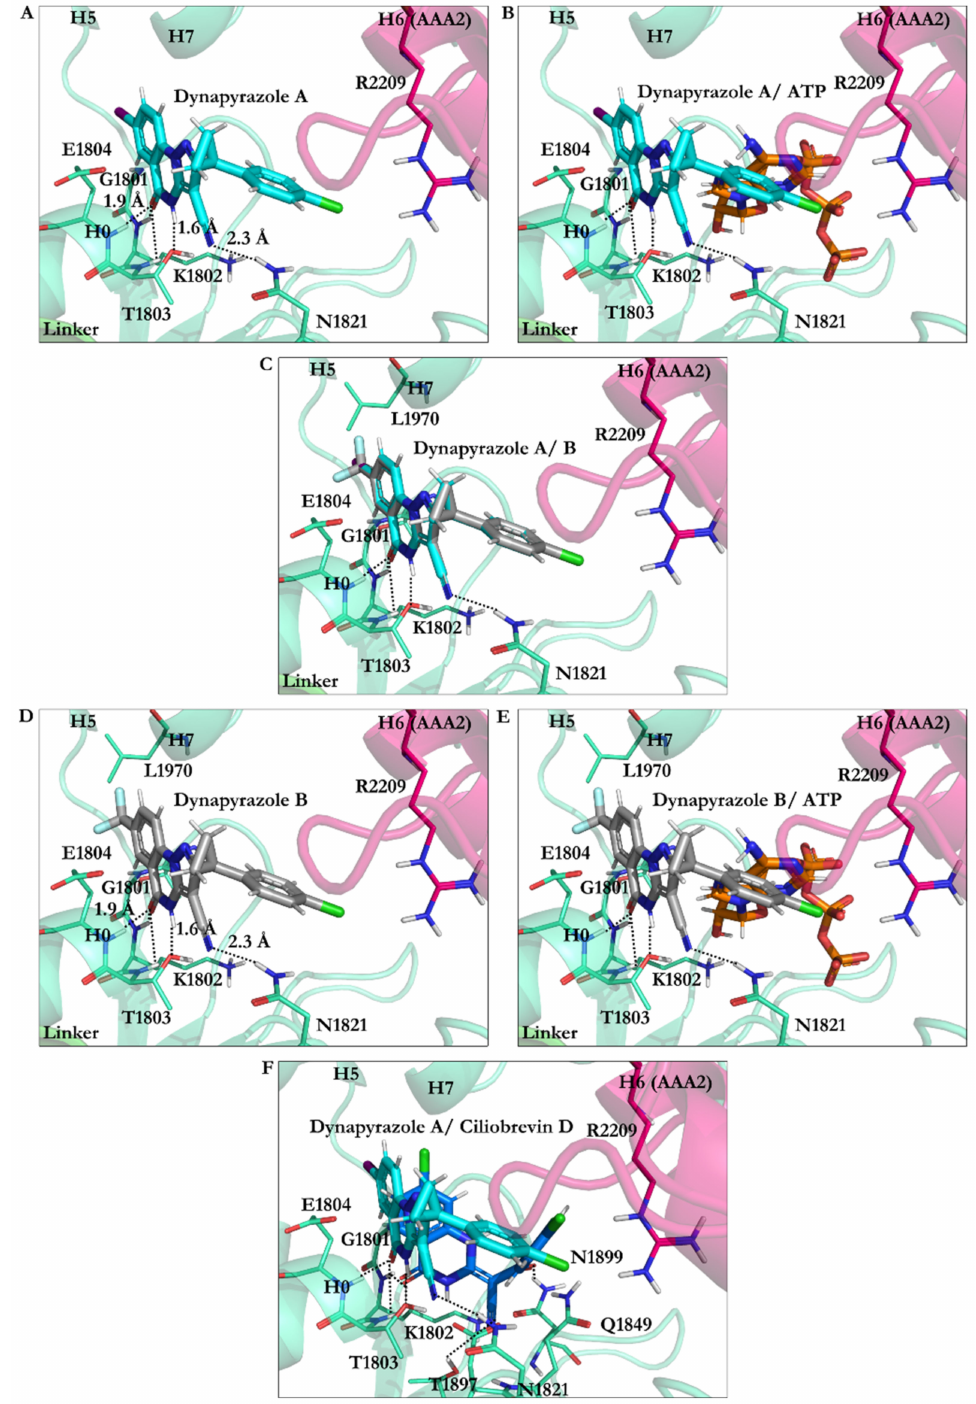
Figure 11. Dynapyrazole in the nucleotide-binding site of the AAA1 ( A ) dynapyrazole A. ( B ) Super- imposition of dynapyrazole A and ATP. ( C ) Superimposition of dynapyrazole A and B. ( D ) Binding modes of dynapyrazole B. ( E ) Superimposition of dynapyrazole B and ATP. ( F ) Superimposition of dynapyrazole A and ciliobrevin